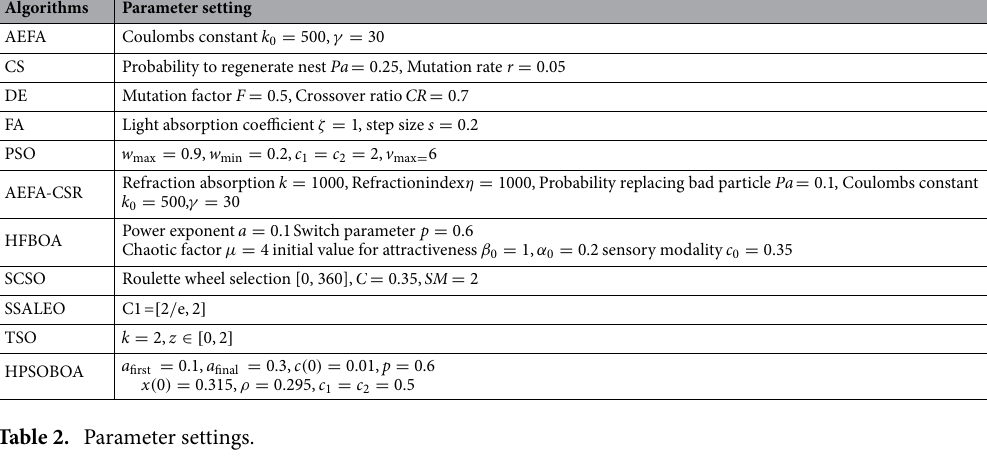
Table 2. Parameter